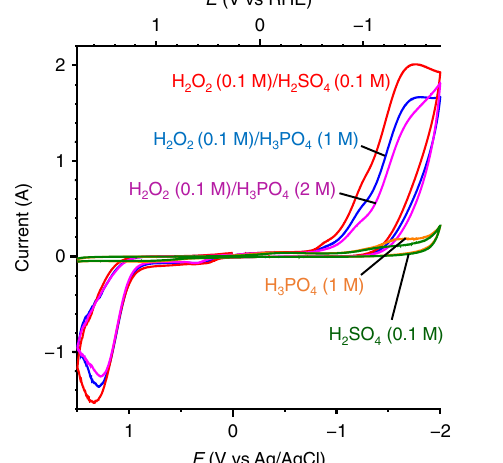
Fig. 3 CV charts measured on a GQDs-loaded grassy carbon electrode in the different solutions. The pH of the solutions is ~1, and all the measurements were carried out under N 2 atmosphere with 0.1 M Na 2 SO 4 and at a scan rate of 0.1 V s − 1 .